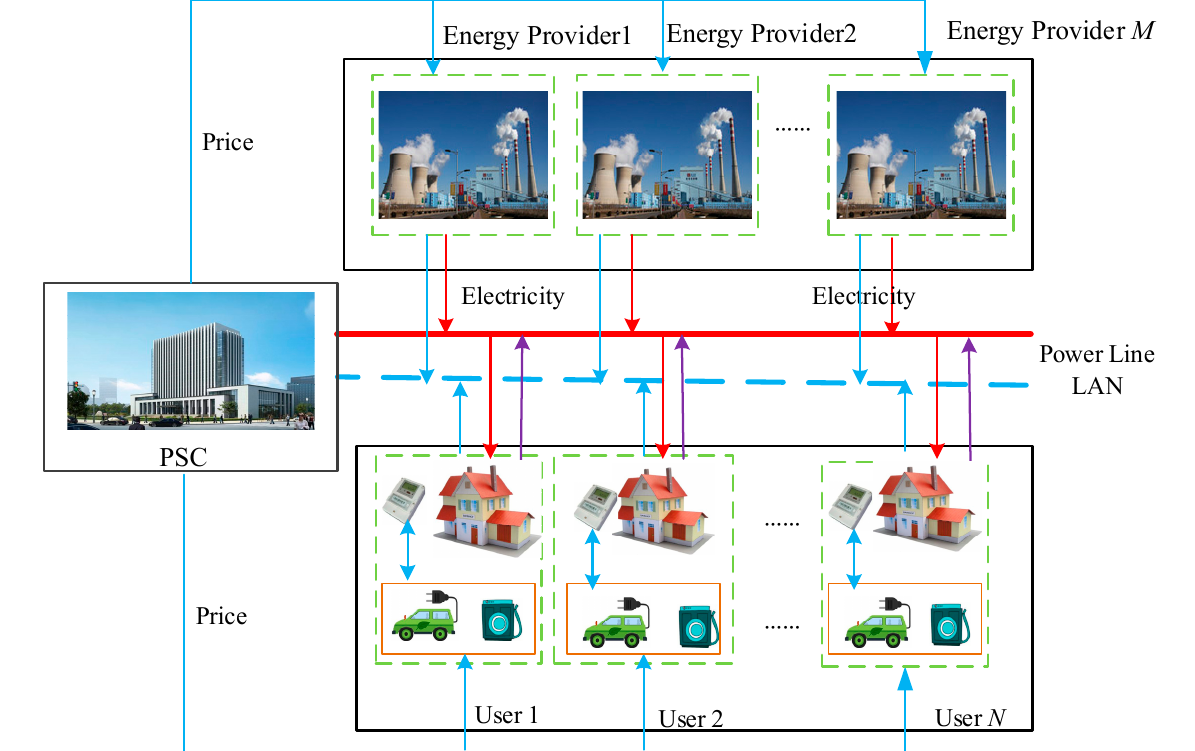
Figure 1. Microgrid with multiple energy providers. (Red is electricity resources, blue is price information, and purple is electricity consumption information.)